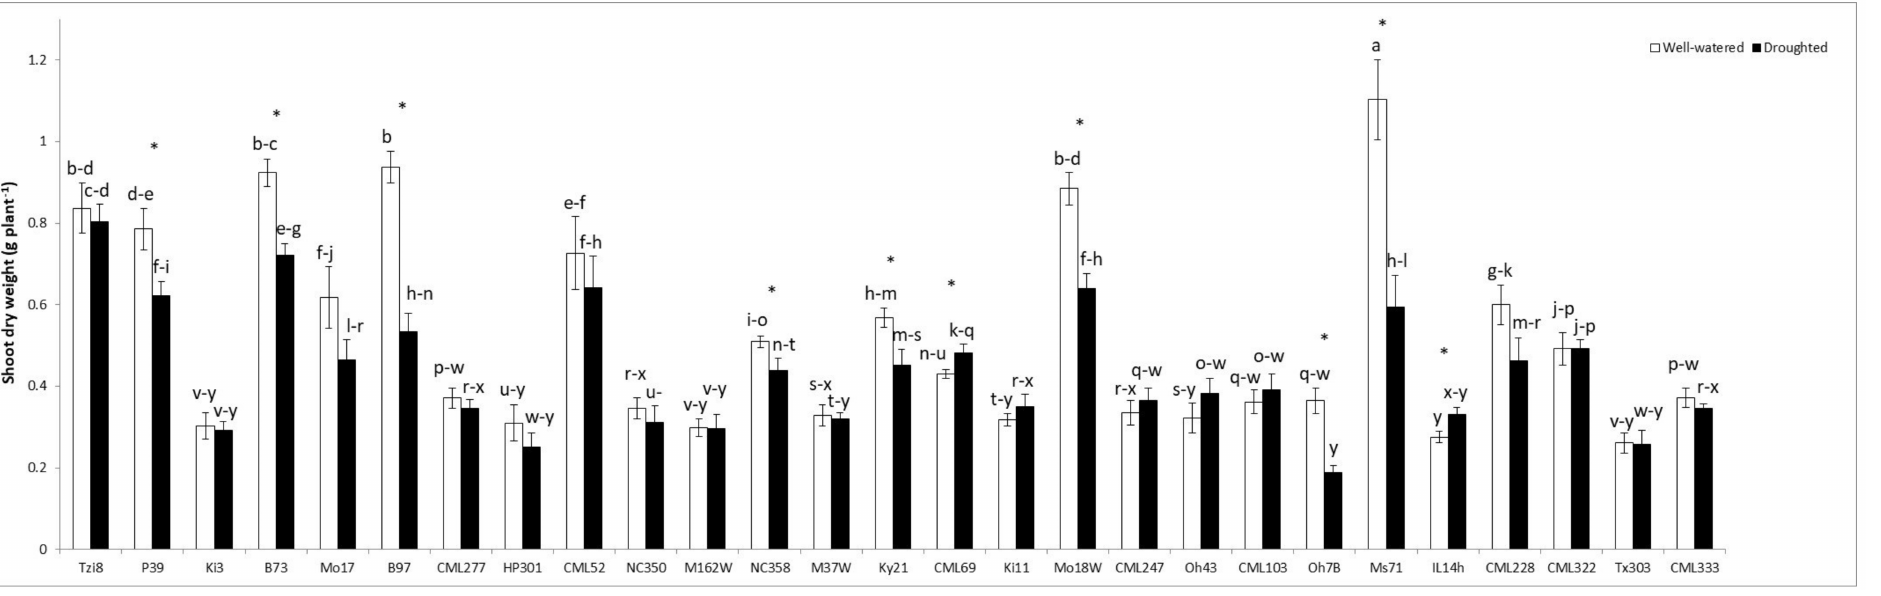
Figure 1. Shoot dry weight in the whole maize NAM population cultivated under well-watered conditions or subjected to drought stress. Data represents the means of 10 values ± S.E. Different letters indicate significant differences between treatments ( p < 0.05) based on Duncan’s test. Asterisks indicate significant differences between well-watered and droughted treatments within each maize line, according to Student’s t